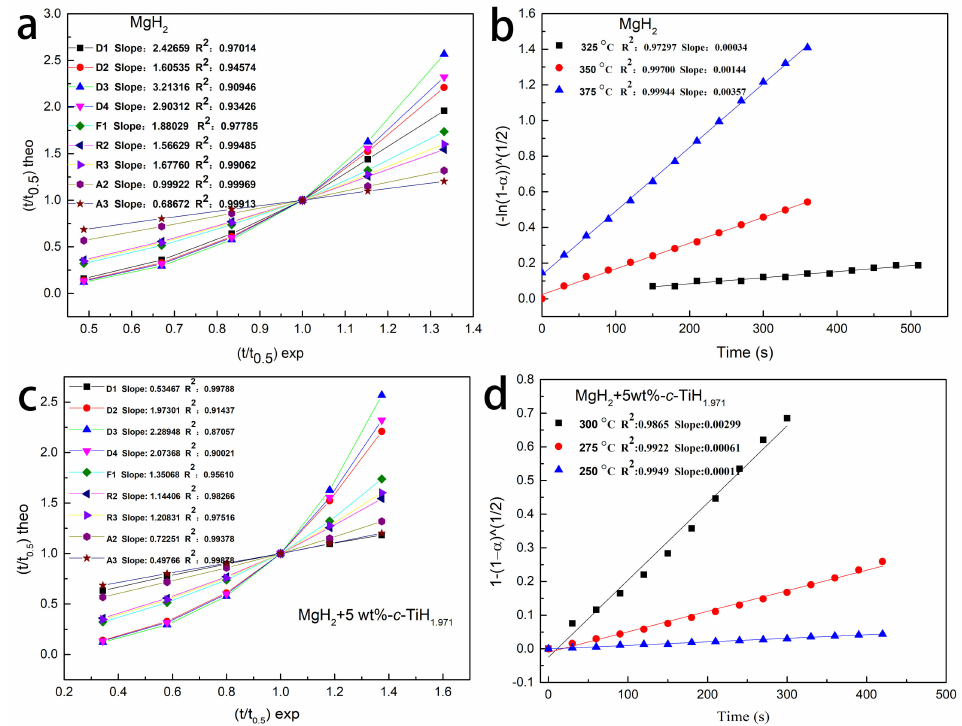
Figure 4. The (t / t 0.5 )theo vs. (t / t 0.5 )exp ( a ) for MgH 2 at 375 ◦ C using various kinetic models, the time dependence of the kinetic modeling equation ( b ) for MgH 2 at di ff erent temperatures. The (t / t 0.5 )theo vs. (t / t 0.5 )exp ( c ) for MgH 2 + 5 wt%- c -TiH 1.971 at 300 ◦ C using various kinetic models. The time dependence of the kinetic modeling equation ( d ) for MgH 2 + 5 wt%- c -TiH 1.971 at di ff erent